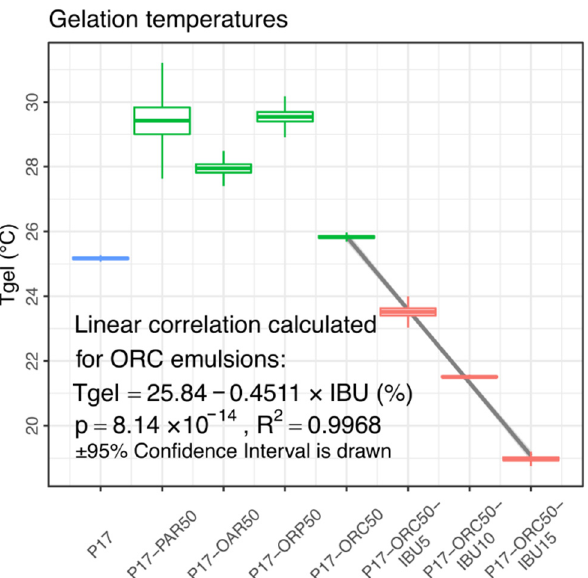
Figure 10. Gelation temperatures in tested formulations. A strong negative linear correlation between Tgel and IBU content is observed in the ORC series over the whole range of IBU content.